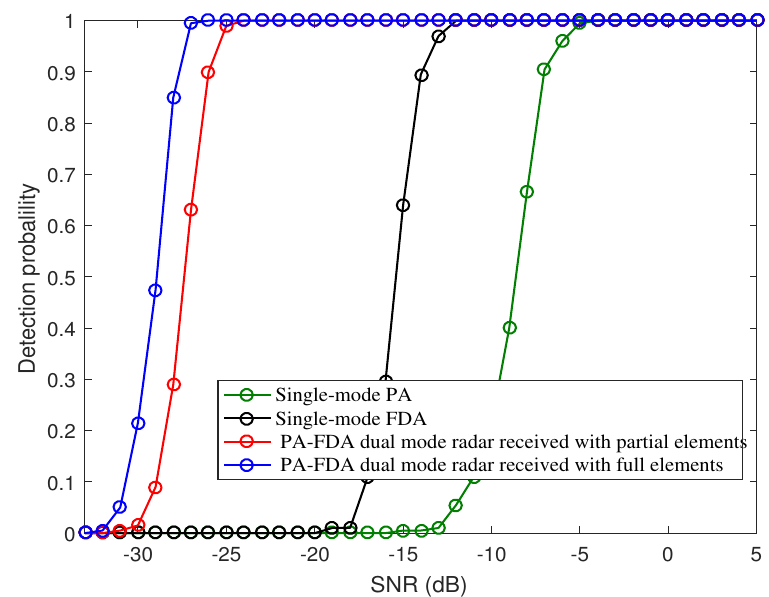
Figure 10. Target detection probability